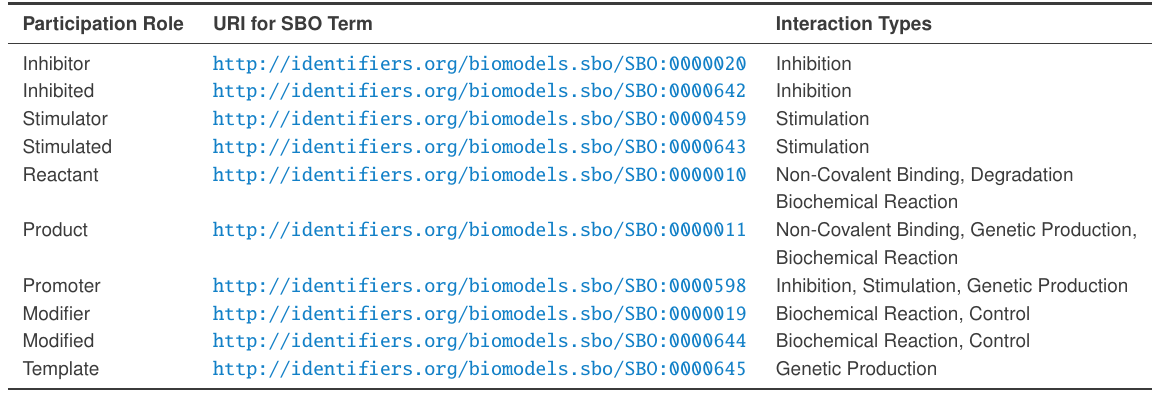
Table 14: SBO terms to specify the roles property of a Participation